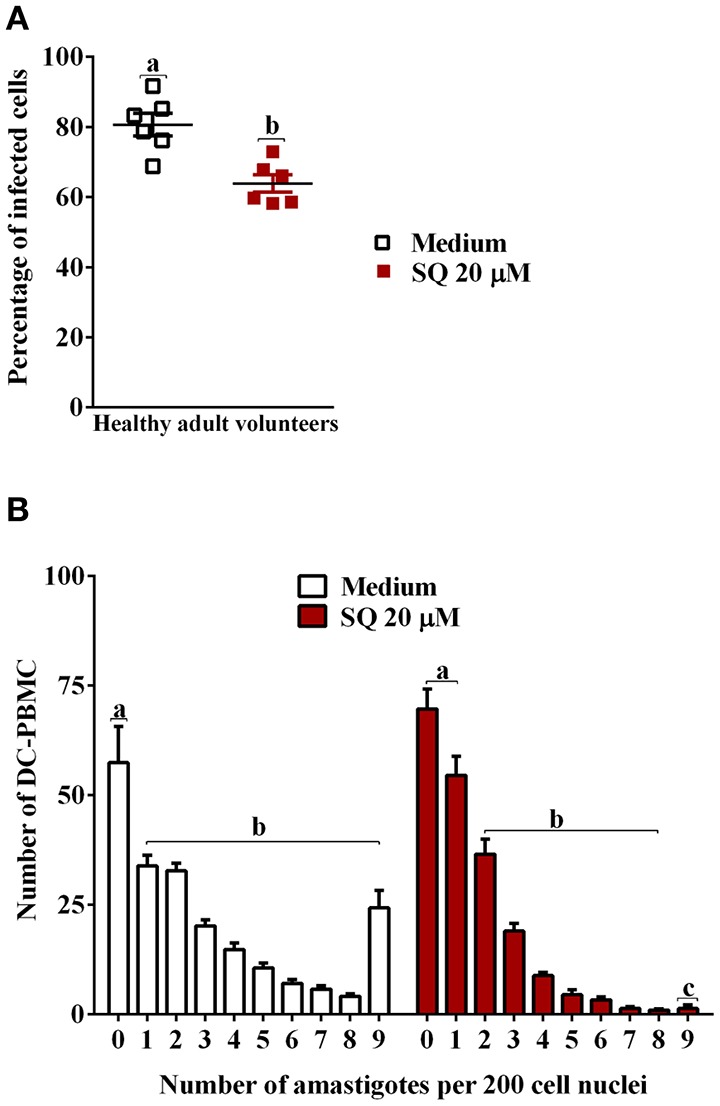
Adenylate-cyclase activity regulates the entry of T. cruzi into DC-PBMC. DC-PBMC were treated for 30 min separately either with or without SQ 22536 (20 μM) and exposed to 5:1 trypomastigotes of T. cruzi (Y strain) during 18 h. Inhibition of adenylate-cyclase decreases T. cruzi infection (A). Number of infected DC-PBMC with nine amastigotes per cell decreased with the treatment (B). Results are the mean ± standard error for duplicate determinations, with five (A) and six (B) blood donors in each experiment. Means not sharing letter are significantly different (P < 0.05, one-way ANOVA with Tukey's post-test).